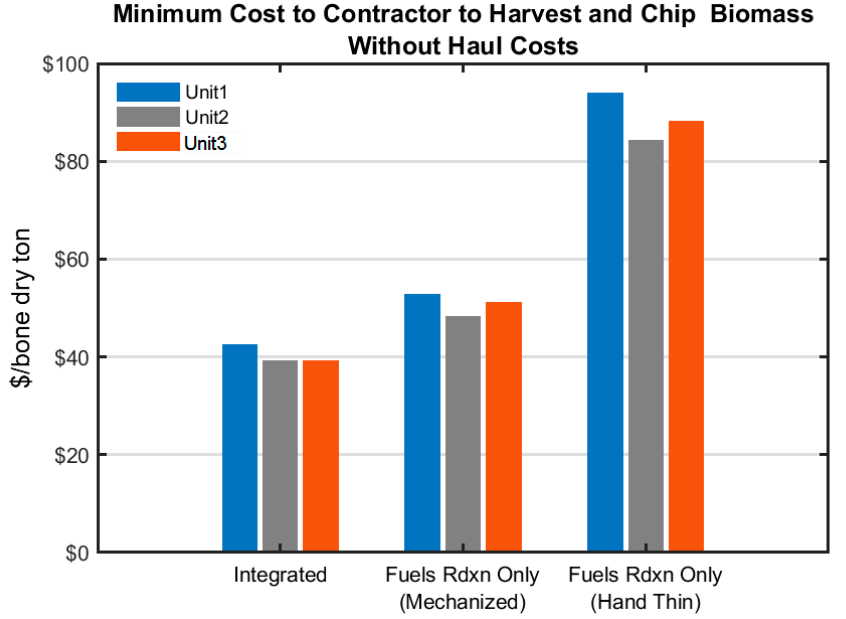
Figure 4. Comparison of treatment costs to harvest and chip biomass across scenarios for each harvest unit—haul costs are not included.